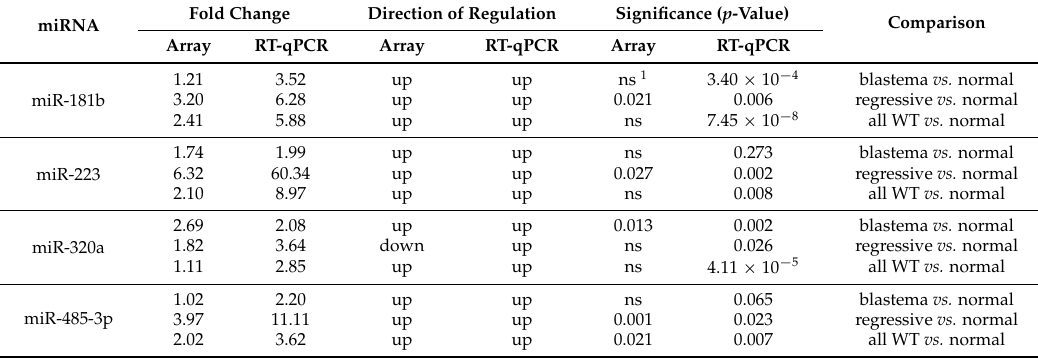
Table 2. Reverse transcription quantitative realtime PCR (RT-qPCR) validation results. Fold Change Direction of miRNA